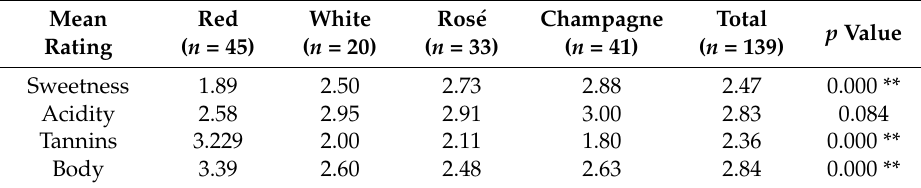
Table A1. Statistical analysis of deep-fried sweet